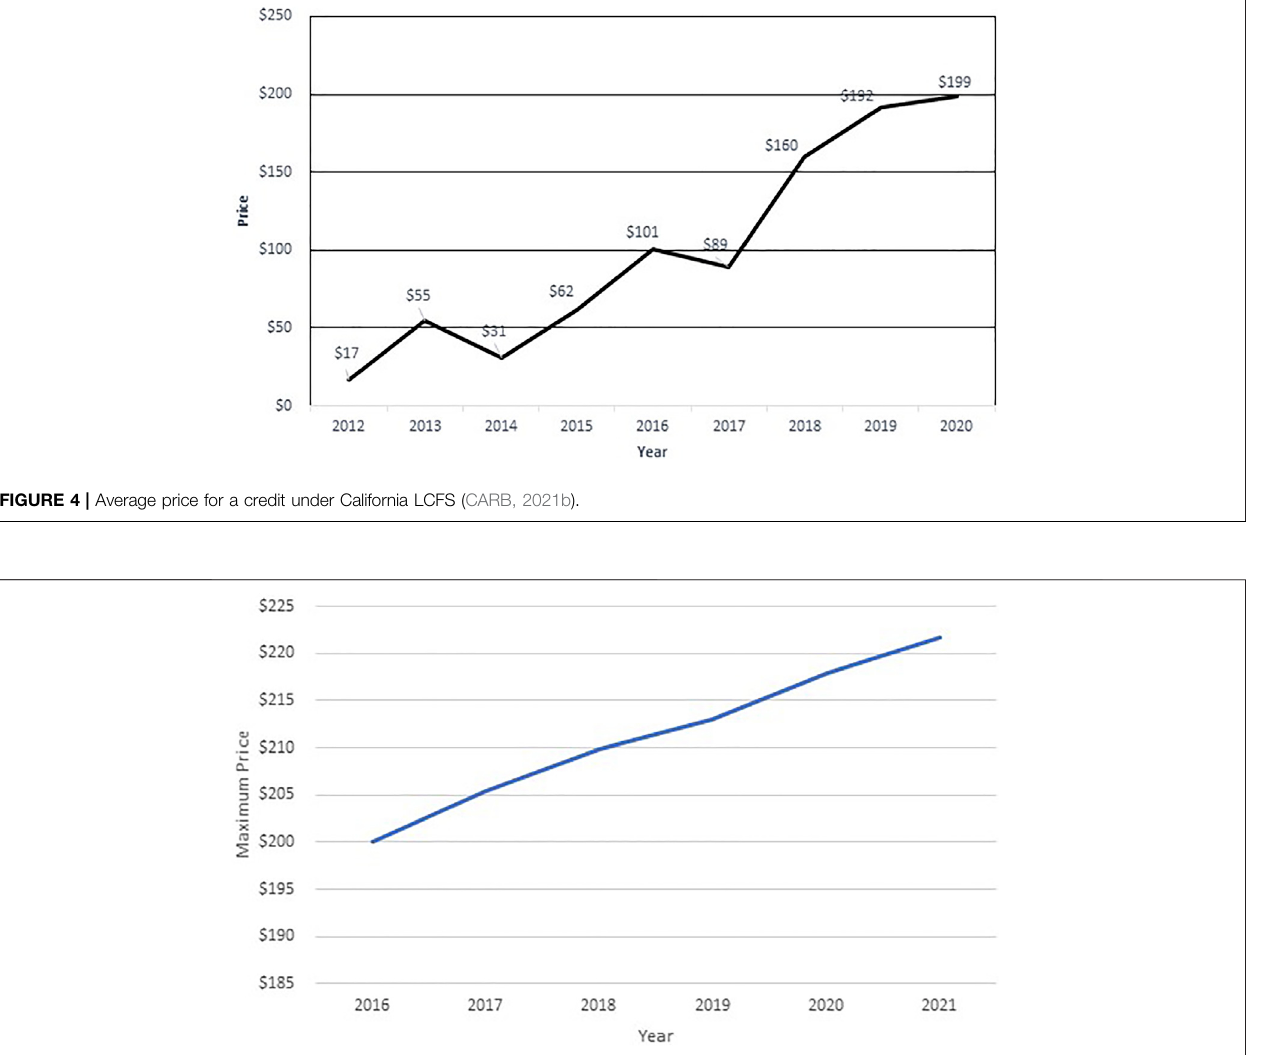
FIGURE 5 | Maximum price for selling a credit each year under LCFS program (CARB, n.d.b).